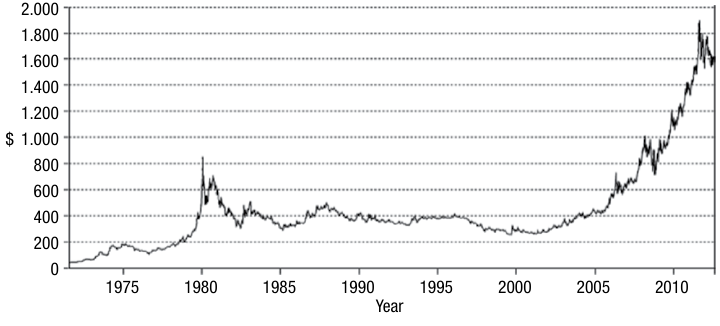
Fig. 1. The trend of gold price, US dollar per ounce Source : World Gold Council,